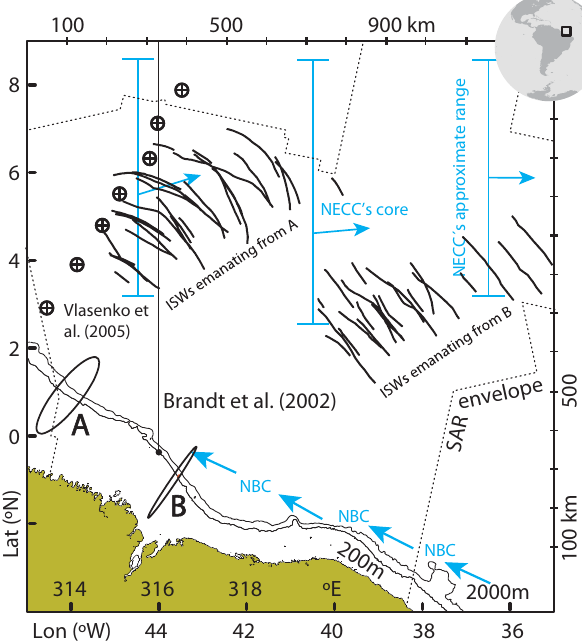
Figure 1. ISW composite map (see inset for location in the trop- ical west Atlantic) with SAR observations limited to the dashed black envelope. Two major current systems are depicted in blue ar- rows: the North Brazilian Current (NBC) and the North Equatorial Counter Current (NECC), with vertical solid lines indicating its ap- proximate range across the study region. Tidal ellipses in black are representative of sites A and B (scaled to a maximum current of 0.5ms − 1 in the across-shelf direction), which represent key areas of ISW generation on either side of a small promontory (near 44 and 0 ◦ N). The shelf break is highlighted by the 200 and 2000m isobaths (in black lines). A meridional section along 44 ◦ W used in Brandt et al. (2002) is shown for reference, together with the approximate location of a series of CTD stations (see circles with black crosses) discussed in Vlasenko et al.